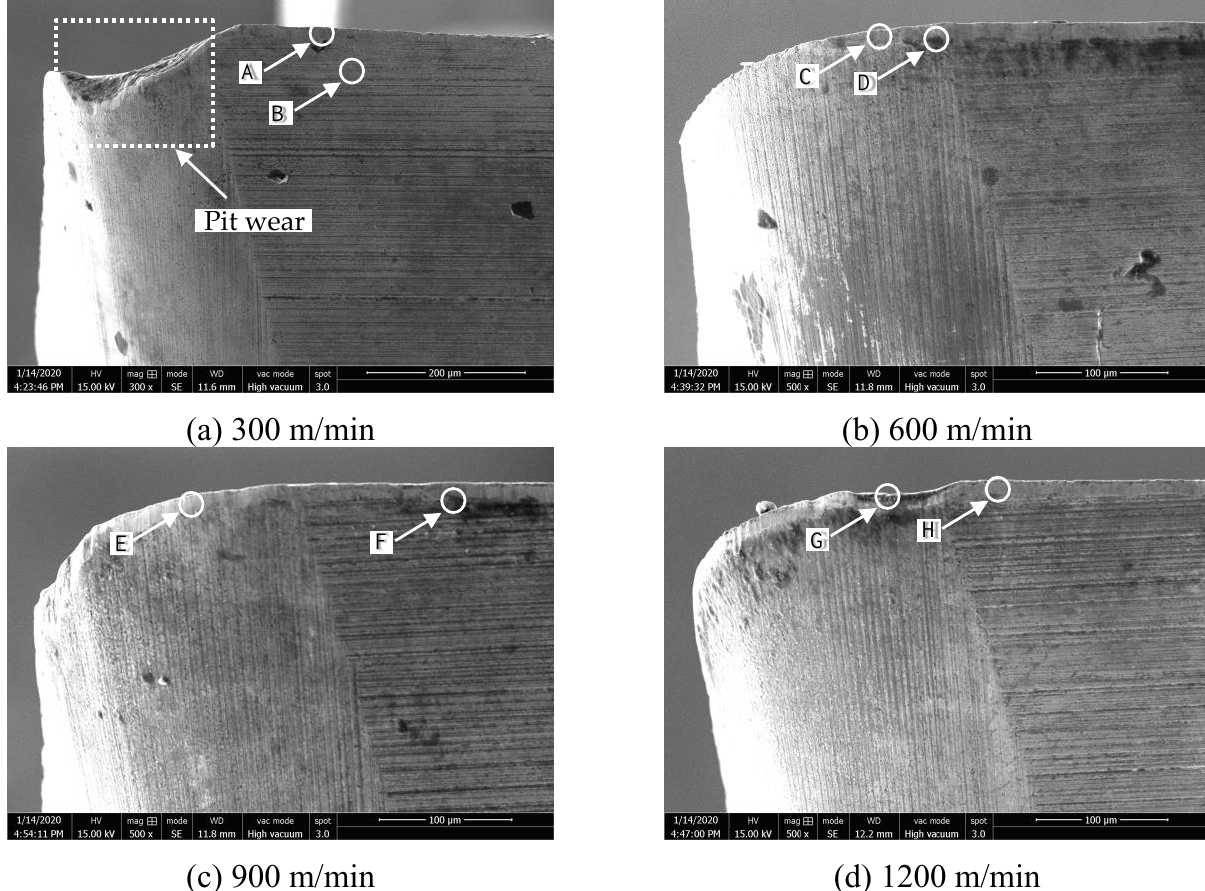
Figure 8. The wear morphology of flank face after milling at different cutting speed (where feed is 0.05 mm/rev, cutting depth is 0.5 mm and cutting width is 3 mm). ( a ) 300 m/min; ( b ) 600 m/min; ( c ) 900 m/min; ( d ) 1200 m/min.